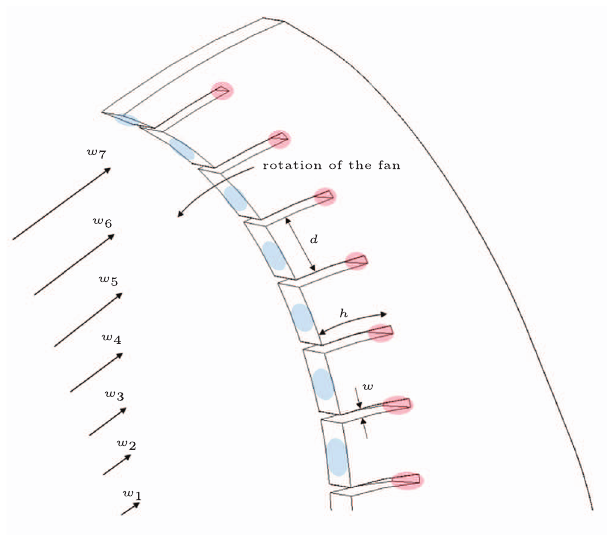
Figure 2. Schematic of a fan blade with the relative velocity w i changing over the span. The areas in which the dominant sound sources are located are marked in blue and red. The design parameters slit width w , slit spacing d and slit height h are shown. The sound sources between leading edge and slit root are separated from each other by the slit height h .